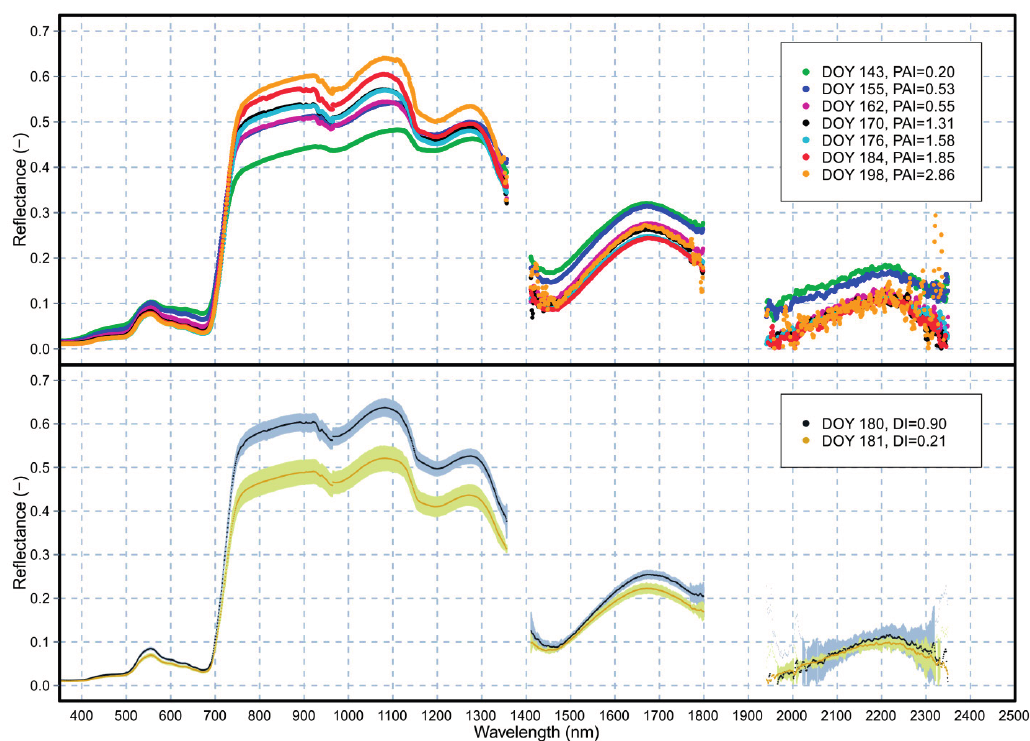
Figure 6. Upper : example of reflectance (daily average) trends starting from DOY 143 until DOY 198, with different Plant Area Index (PAI) values ranging from 0.20 to 2.86 (m 2 ·m − 2 ). Lower : reflectance under sunny (DOY 181; Diffusion Index—DI = 0.21 ( − )) and cloudy conditions (DOY 180; DI = 0.90 ( − )). Error bars in the lower panel represent standard